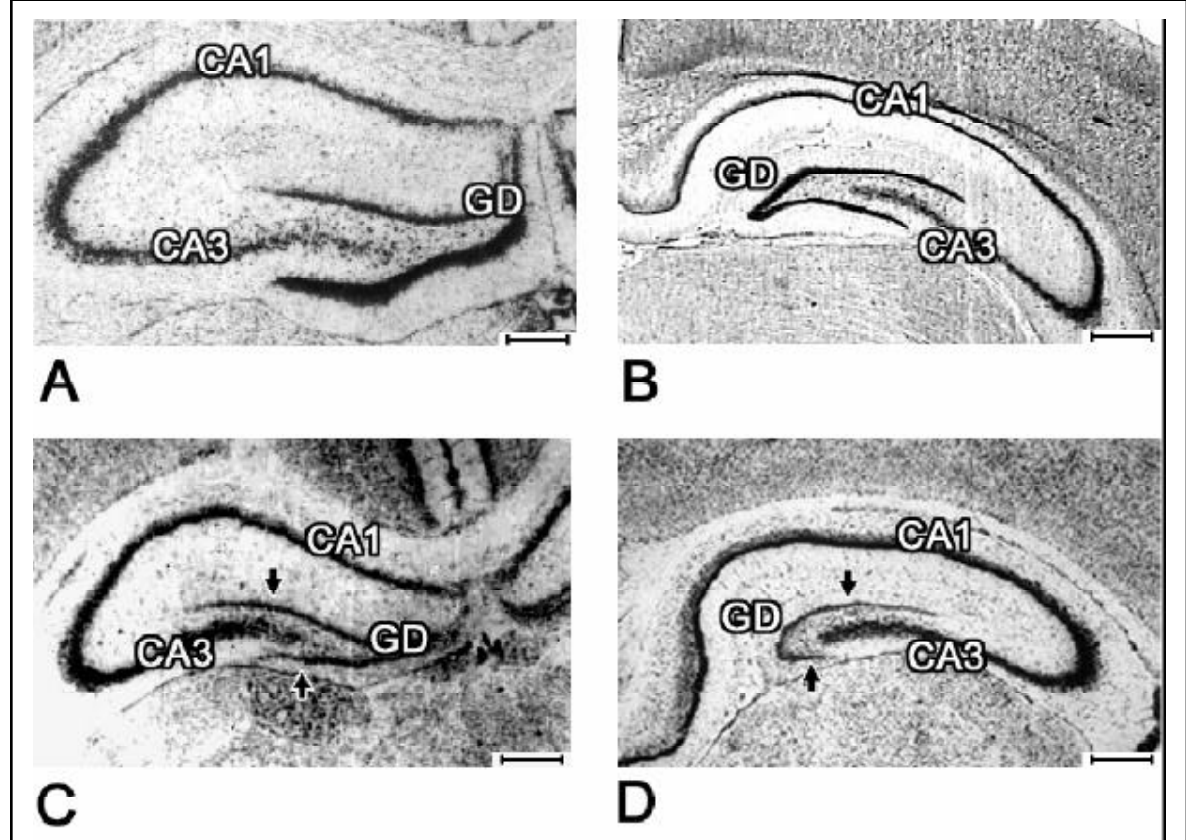
Figura 2. Fotomicrografias de secções coronais do pólo septal do hemisfério direito de animais representativos dos grupos Controle (A) e Irradiado (C) e do pólo intermediário do hemisfério esquerdo dos grupos Controle (B) e Irradiado (D). As secções coronais do grupo Irradiado (C e D) apresentam uma redução média de 79% da área do Giro Denteado (flechas) em relação às secções coronais do grupo Controle (A e B). CA1 e CA3 = Cornos de Ammon do Hipocampo; GD=Giro Denteado. Barra de escala igual a 400